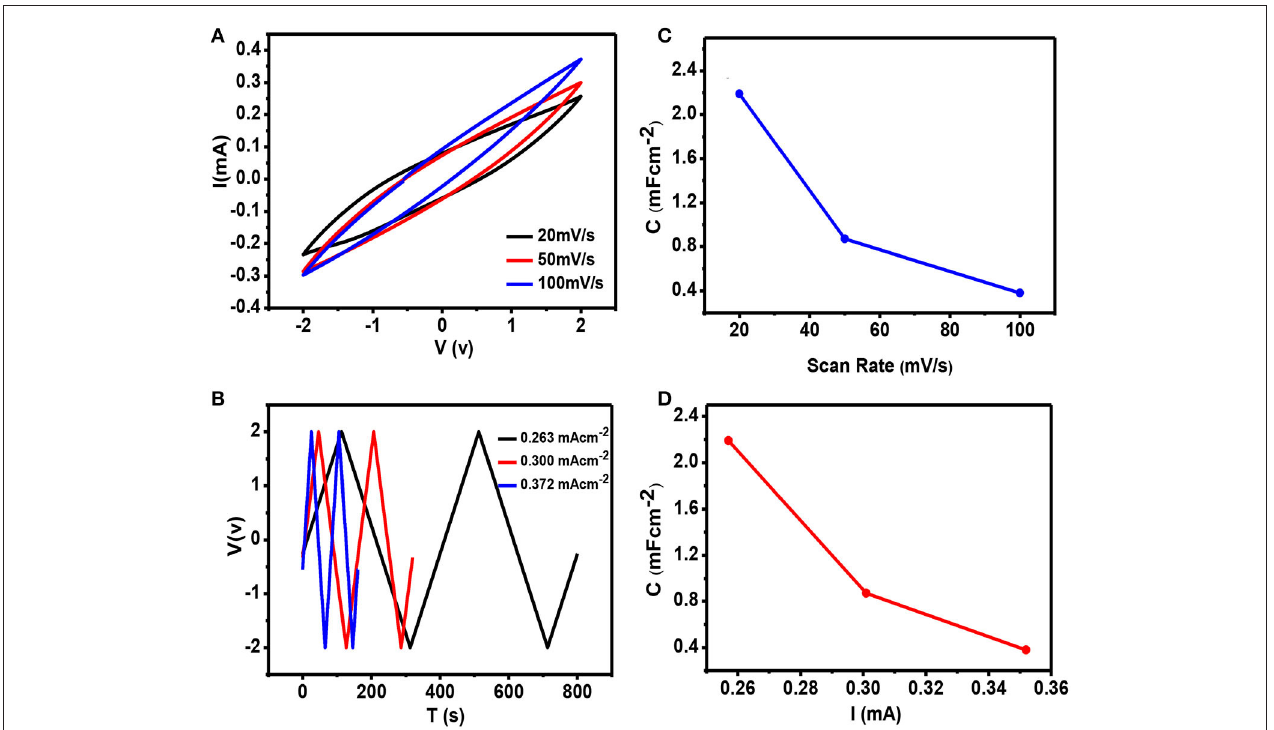
FIGURE 6 | (A) Cyclic voltammetry for the supercapacitor containing Iono-gel at scan rate of 20 mV/s, 50 mV/s and 100 mV/s at the potential window of − 2 to 2V. (B) Charging and discharging curves of the supercapacitor. (C) Decreasing behavior of capacitance at different scan rates and at (D) capacitance and energy density analysis of the proposed